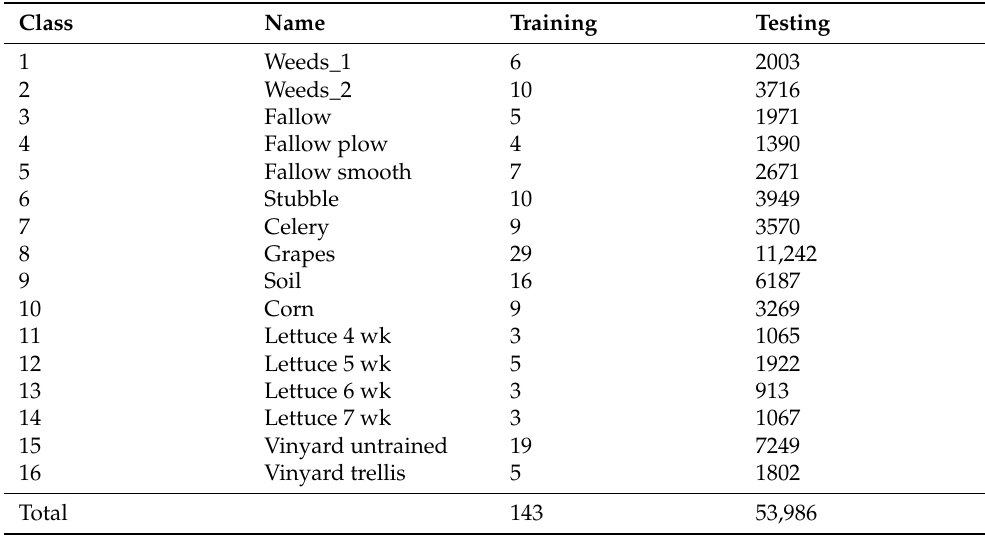
Table 5. Class-based numbers of training and testing samples for Salinas.